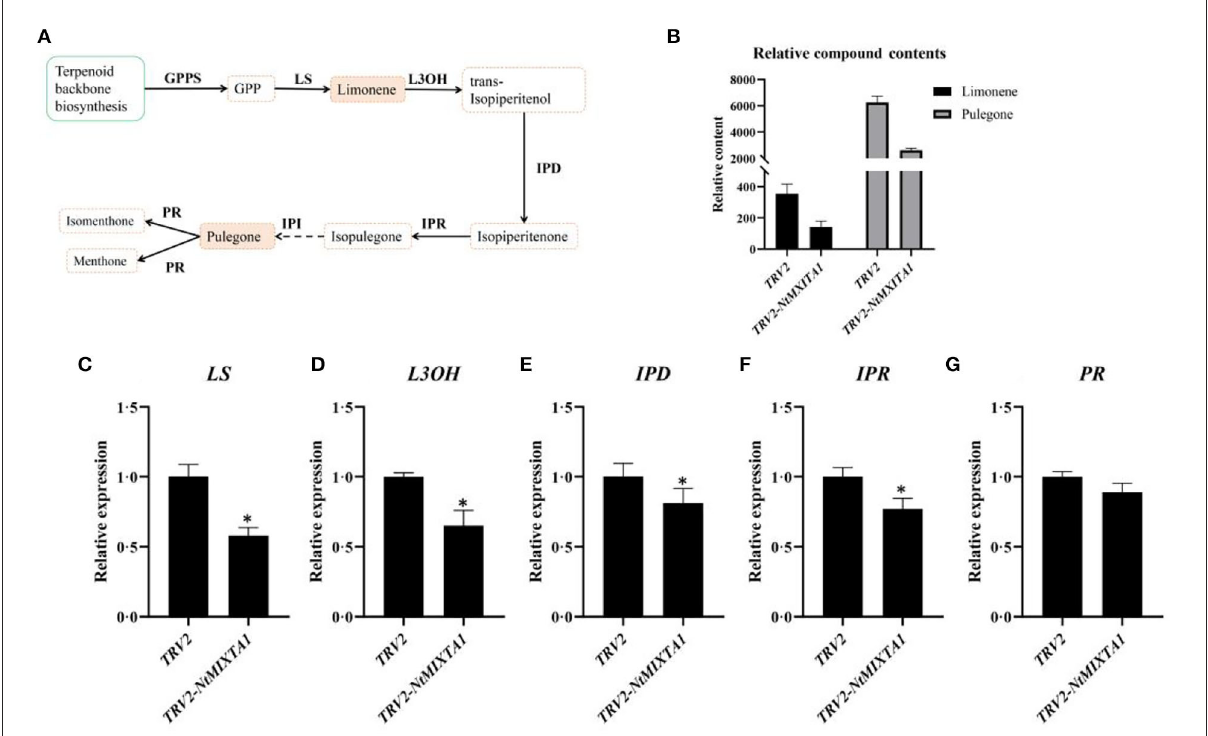
FIGURE4 Variation of gene expression levels and compound contents of menthane monoterpenes biosynthesis. (A) The biosynthesis of menthane monoterpenes; (B) the relative contents of pulegone and limonene in TRV2 and in TRV2- NtMIXTA1 ; (C–G) the expression levels of LS, L3OH, IPR, IPD, and PR in TRV2 and in TRV2- NtMIXTA1 , p -value < 0.05 with β -actin as a reference gene ( n = 3); enzyme abbreviations: GPP, geranyl diphosphate; GPPS, geranyl diphosphate synthase; LS, limonene synthase; L3OH, limonene-3-hydroxylase; IPD, isopiperitenol dehydrogenase; IPR, isopiperitenone reductase; PR, pulegone reductase. * was represented as p-value <